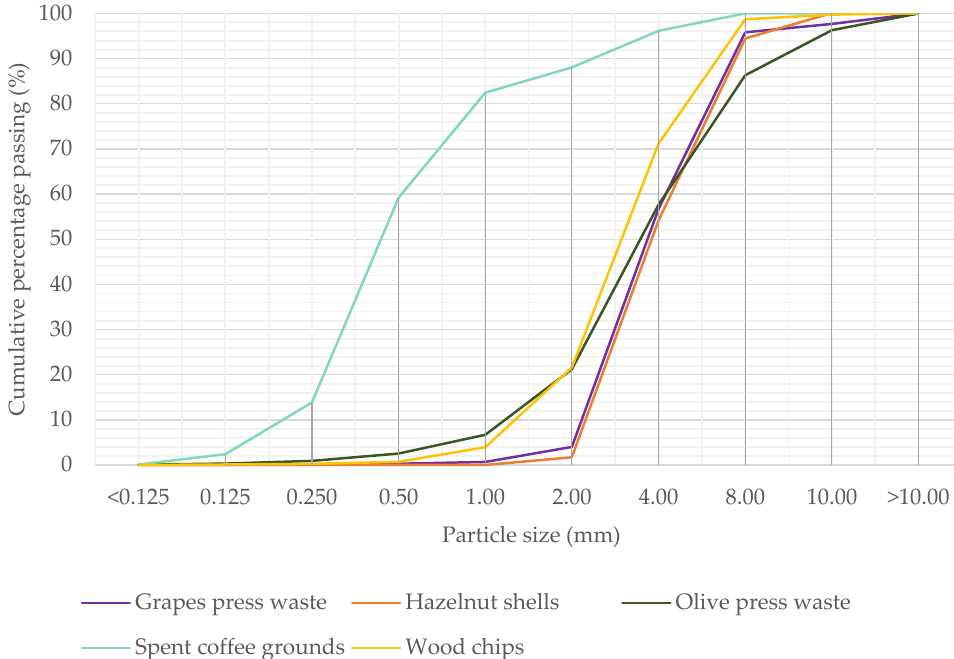
Figure 3. Particle size distribution of the tested bio-wastes and the wood chips.